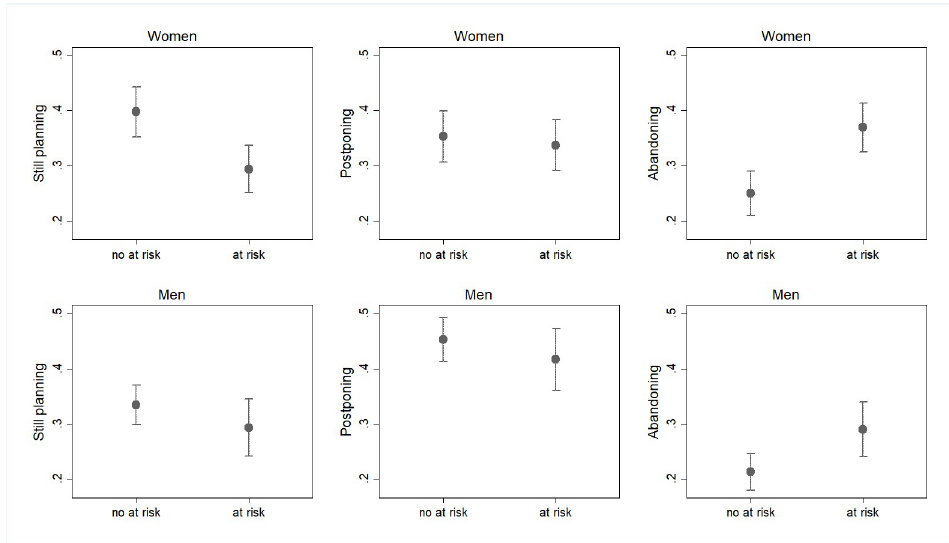
Fig 5. Predicted probabilities of changes or confirmations of pre-COVID fertility plans in March and October 2020 for those who perceived and those who do not perceived their future income as at risk (confidence intervals for pair-wise comparisons at the 5% significance level; March and October 2020 wave pooled). Note: Predicted probabilities bases on a multinomial logit model, controlling for age class, education, marital status, presence of children. Full results are available in S1_2 and S1_3 Tables in S1 Appendix. Confidence intervals are calculated to allow for multiple comparisons of predicted probabilities, i.e., to allow testing their statistical equality at an approximate 5% significance level. Overlap between a pair of intervals indicate that the corresponding predicted probabilities are not statistically different at the 10% level, while non-overlap indicate a significant difference. No differences in terms of significancy has been found with confidence intervals at